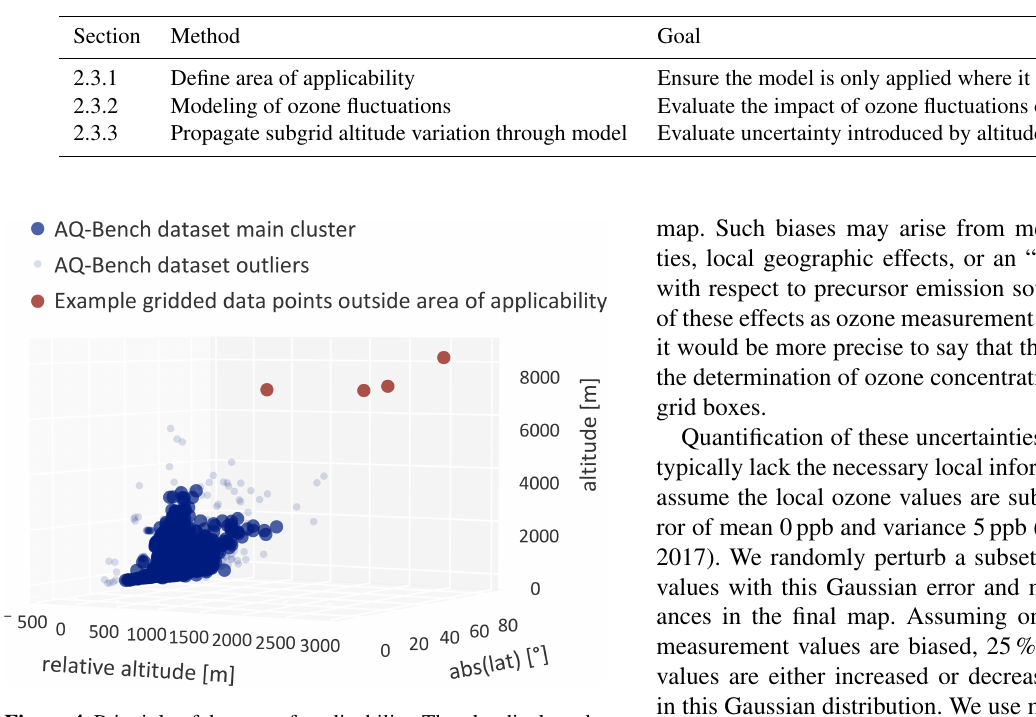
Figure 4. Principle of the area of applicability. The plot displays the distribution of all AQ-Bench samples along the three most impor- tant feature axes “absolute latitude”, “altitude”, and “relative alti- tude”. It is clearly visible that the AQ-Bench samples form a cluster, and that some feature combinations in the gridded data are far away from this